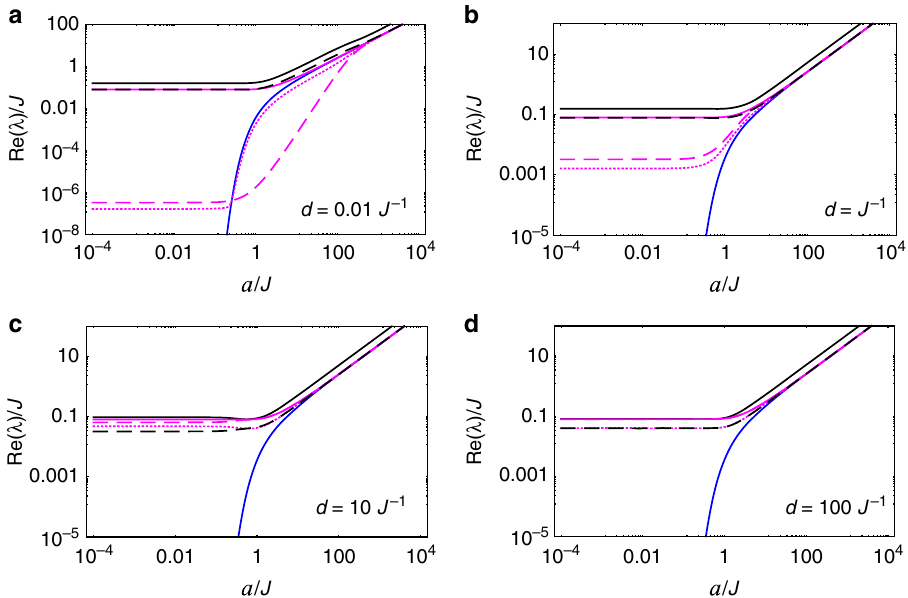
Fig. 2 Acceleration dependence of relaxation/decoherence rates of the spin system with equal proper accelerations. We plot the decay rates (normalized by q 2 ), Re( λ k ) — k = 2 (solid, black line), 3 (dashed, magenta line), 4, 5, 6 (solid, blue line), 7, 8, 9, 10 (dotted, magenta line), 11, 12, 13, 14 (dashed, black line), 15, 16 (solid, magenta line) — of the decaying modes of the spin system, as functions of the spins ’ acceleration a , for different separations d . Unless d ≪ J − 1 — in which case mode ^ ρ dominates the late-time dynamics for J ≲ a ≲ d (cid:2) 1 — modes ^ ρ 3 how the system approaches equilibrium with a relaxation/decoherence rate given by q 2 J /[8 π (e π J / a −